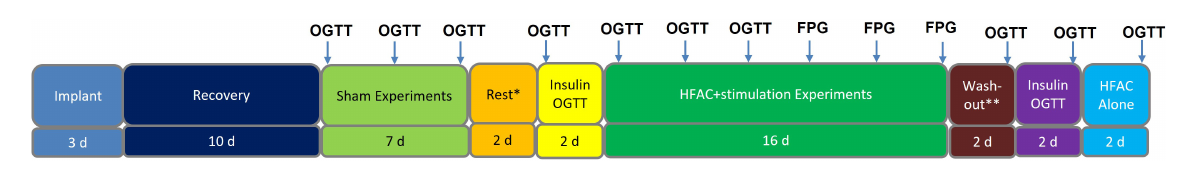
FIGURE4 Study timeline for Alloxan treated swine experiments. Each arrow indicates an experiment. Each experiment was conducted in 1 day. There were 2 days of separation between Sham oral glucose tolerance tests (OGTTs) as well as 2 days of separation between high frequency alternating current (HFAC) + stimulation OGTTs and fasting plasma glucose (FPG) experiments. In Sham and OGTT experiments FPG was the baseline blood sample (swine were fasted 18 h prior to all experiments). ∗ Rest involves recovery from OGTTs. ∗∗ Depicts rest period prior to washout OGTT.